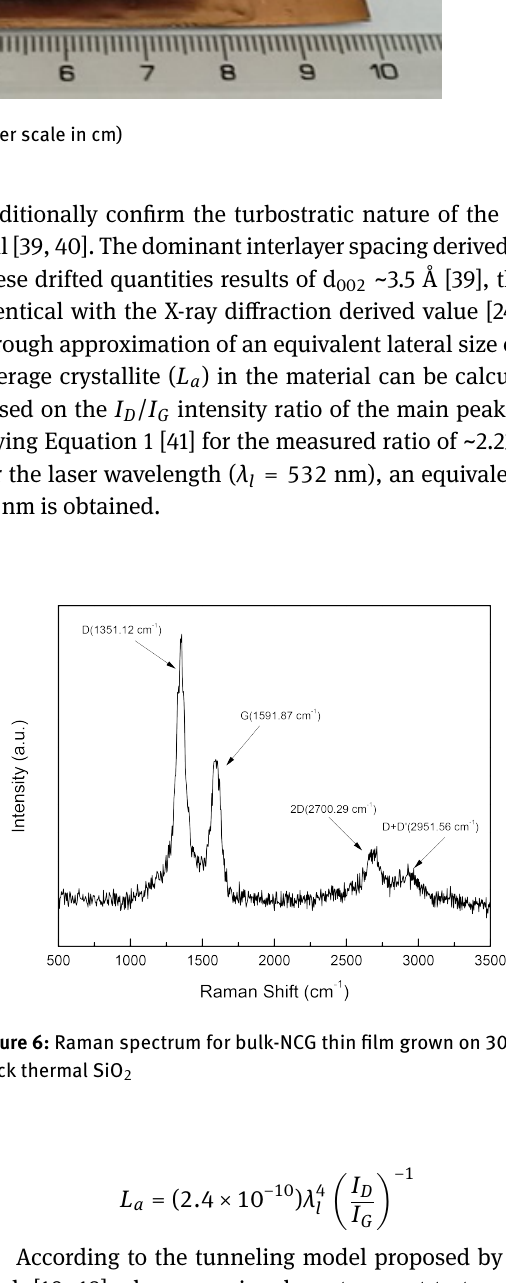
Figure 5: PDMS/NCG/PDMS sample used for electromechanical testing (ruler scale in cm)